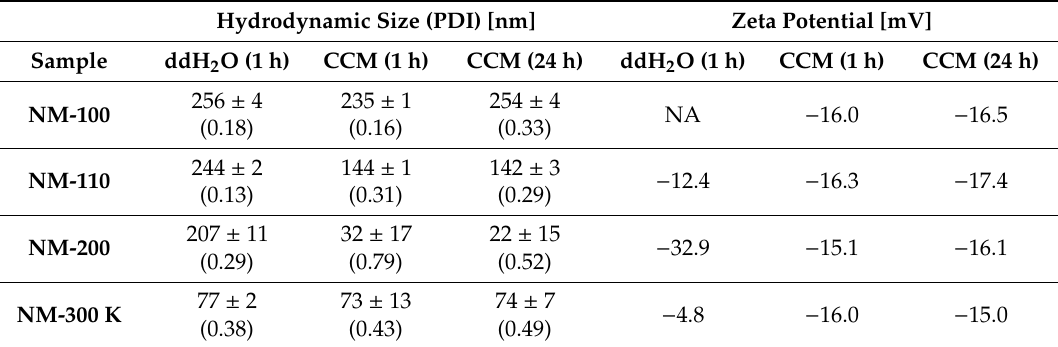
Table 3. Particle size distribution and zeta potential of NP dispersions (NP concentrations